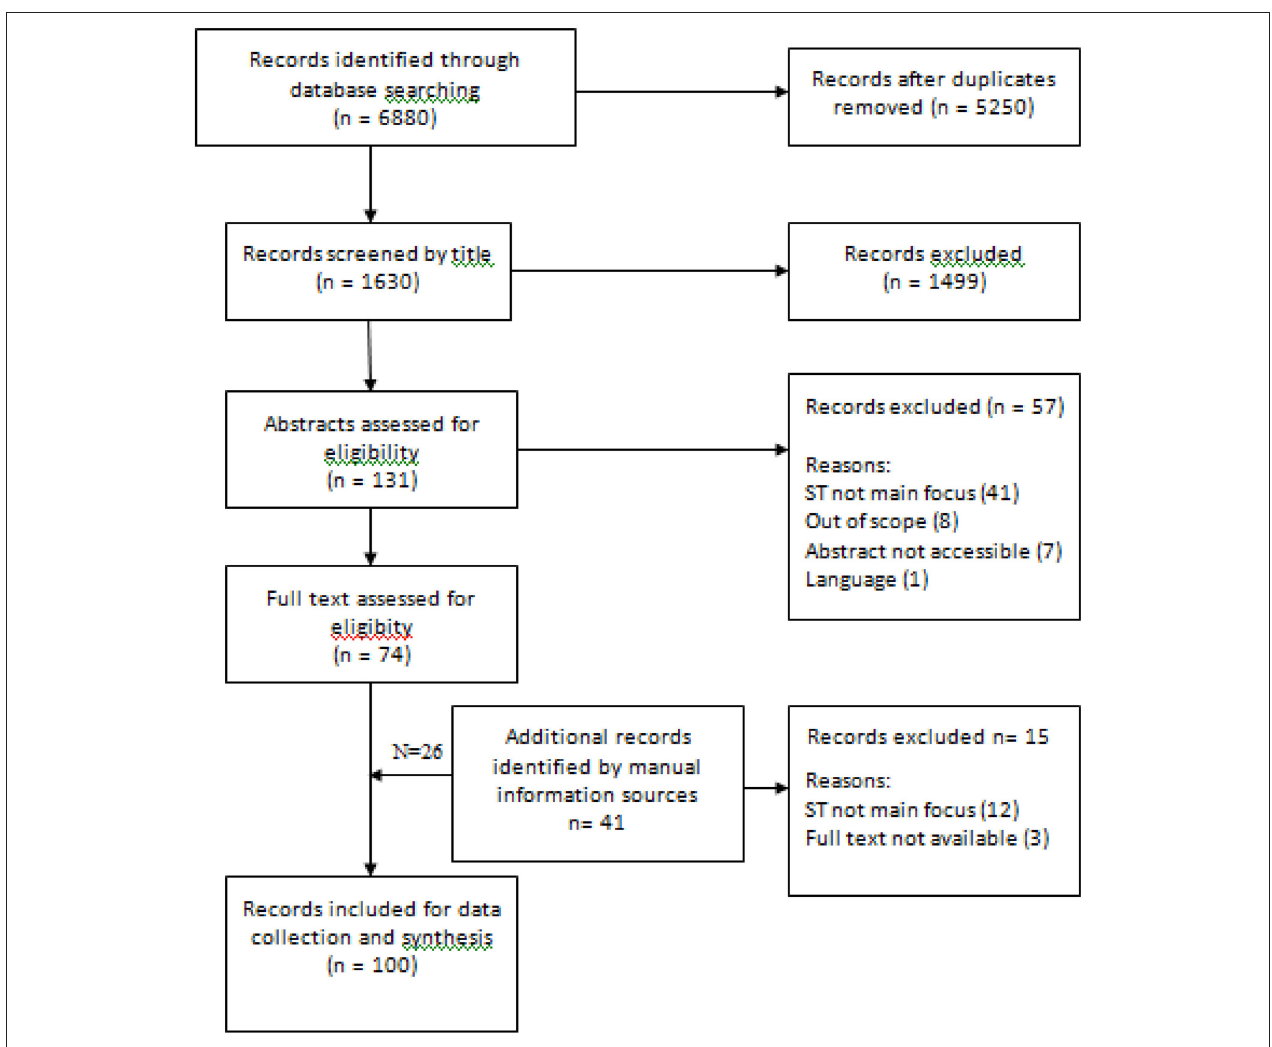
FIGURE 1 | Flow chart of study